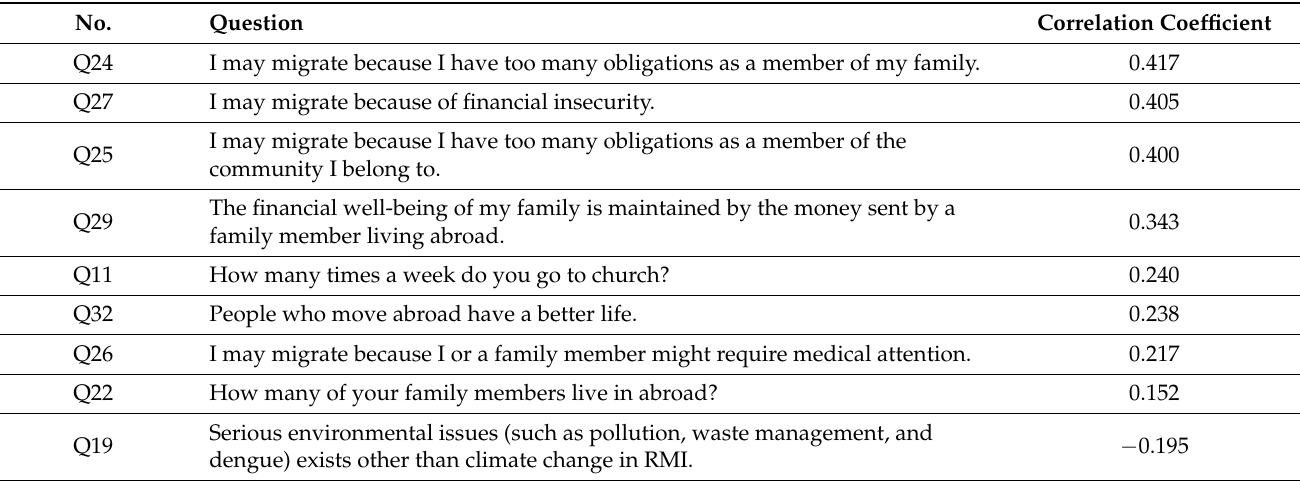
Table 3. Questions correlated at a significance level of 99% or higher with motivation to